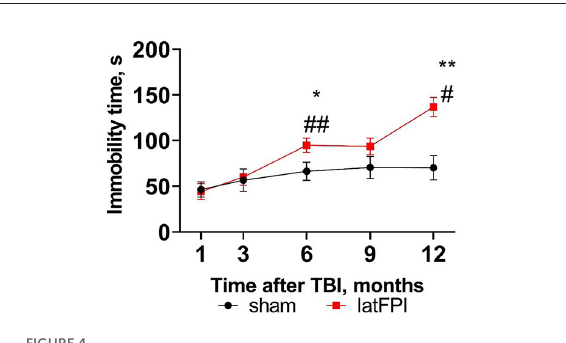
FIGURE4 Depressive-like behavior was determined by the time spent immobile in the tail suspension test 1, 3, 6, 9, and 12 months after latFPI. Data are expressed as mean ± SEM. * p < 0.05, ** p < 0.01 vs. sham, # p < 0.05, ## p < 0.001 compared to 1 month (two-way RM ANOVA followed by Fisher’s LSD